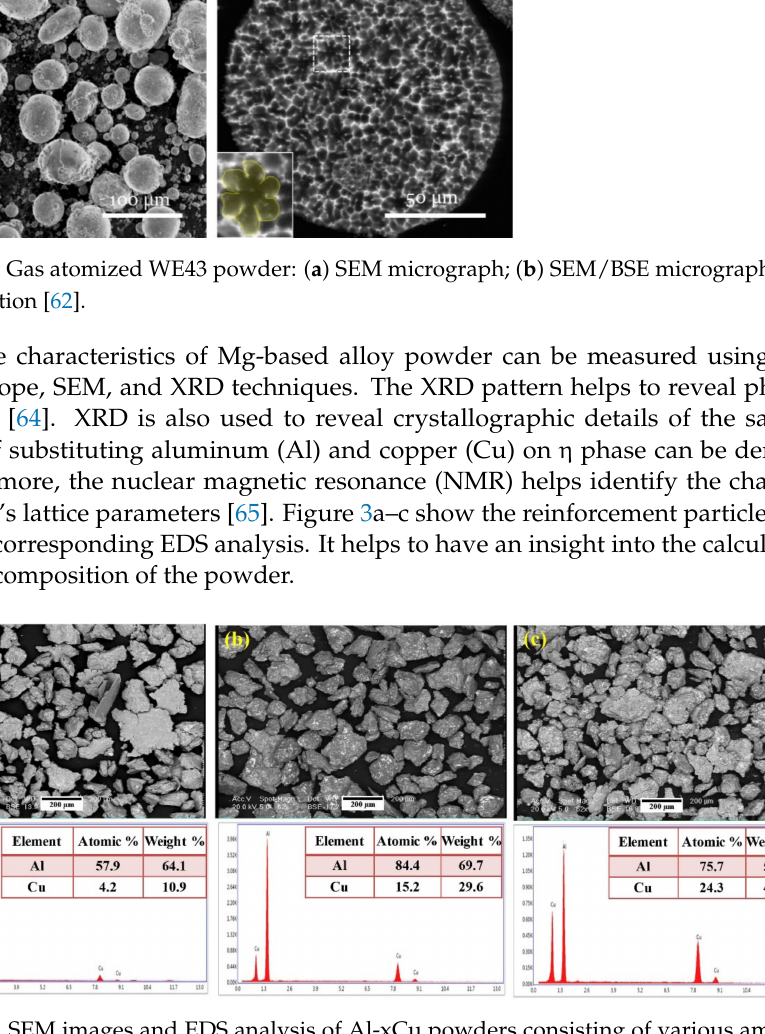
Figure 3. SEM images and EDS analysis of Al-xCu powders consisting of various amounts of Cu: ( a ) x = 20, ( b ) x = 33 and ( c ) x = 50